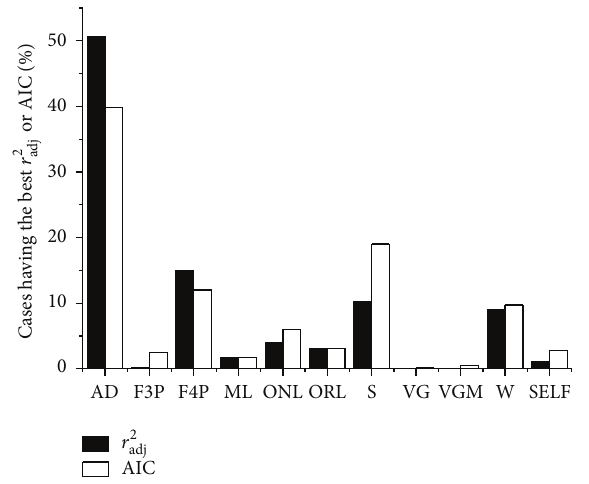
Figure 3: Percentage of soils of T3 scheme for which 𝑟 2 the best for a given